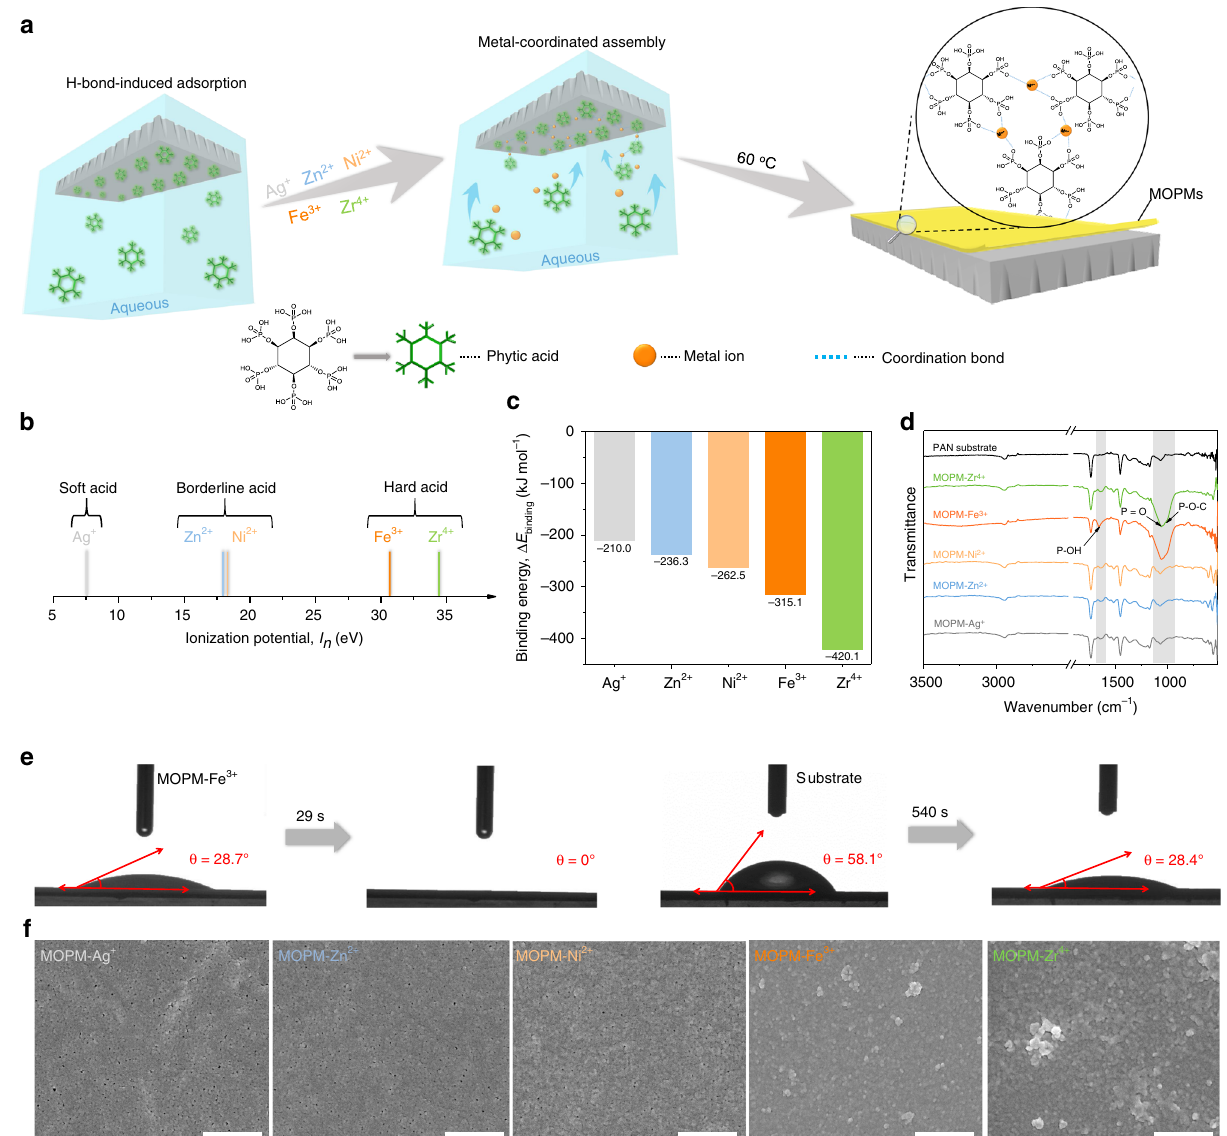
Fig. 1 Metal-coordinated assembly of MOPMs. a Schematic illustration of the assembly process for MOPMs on PAN substrate with Ag + , Zn 2 + , Ni 2 + , Fe 3 + , and Zr 4 + ions. b Transition metal ions arranged based on ionization potential ( I n , eV) value. The ionization potential de fi ned as: I n = E (M) − E (M n + ), where n = 1, 2, 3, 4. c Calculated binding energy ( Δ E binding , kJ mol − 1 ) between transition metal ions and deprotonated methyl phosphate. d FTIR curves of PAN substrate and MOPMs. e Digital photo images of water droplets on PAN substrate and MOPM-Fe 3 + membrane. f SEM images of MOPMs. Scale bar: 500